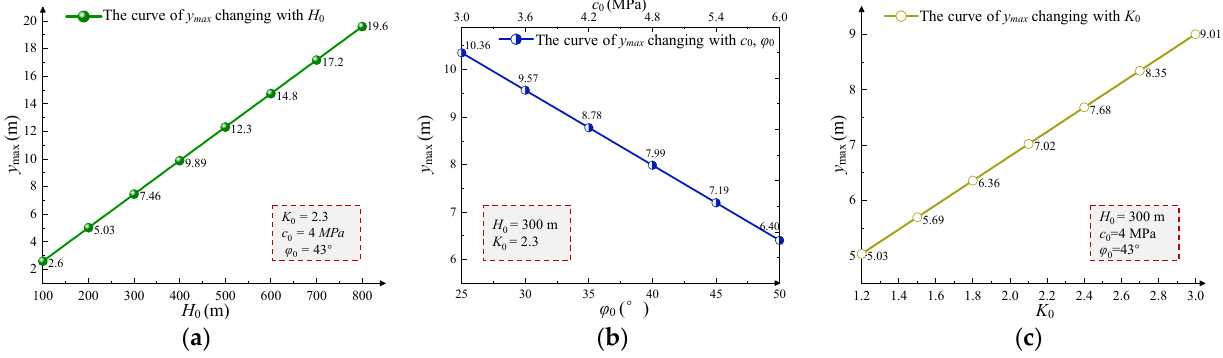
Figure 2. Influence of various parameters on the maximum damage depth of the floor. ( a ) The effect of H 0 on y max ( b ) The effect of c 0 and φ 0 on y max ( c ) The effect of K 0 on y max . It can be seen from Figure 2a that the maximum damage depth of the bottom plate increases by 7.5 times when the buried depth is increased by eight times. This depth